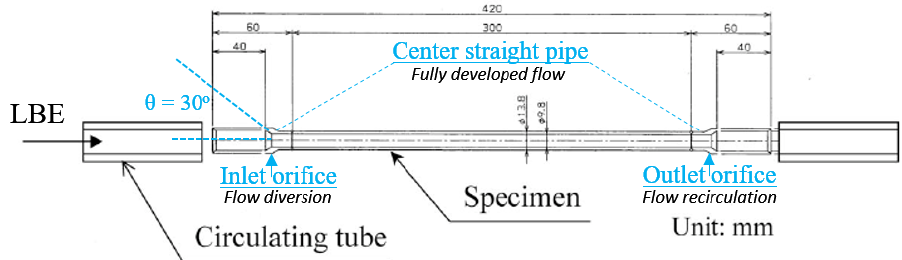
Figure 5. Geometry of specimen tubing.